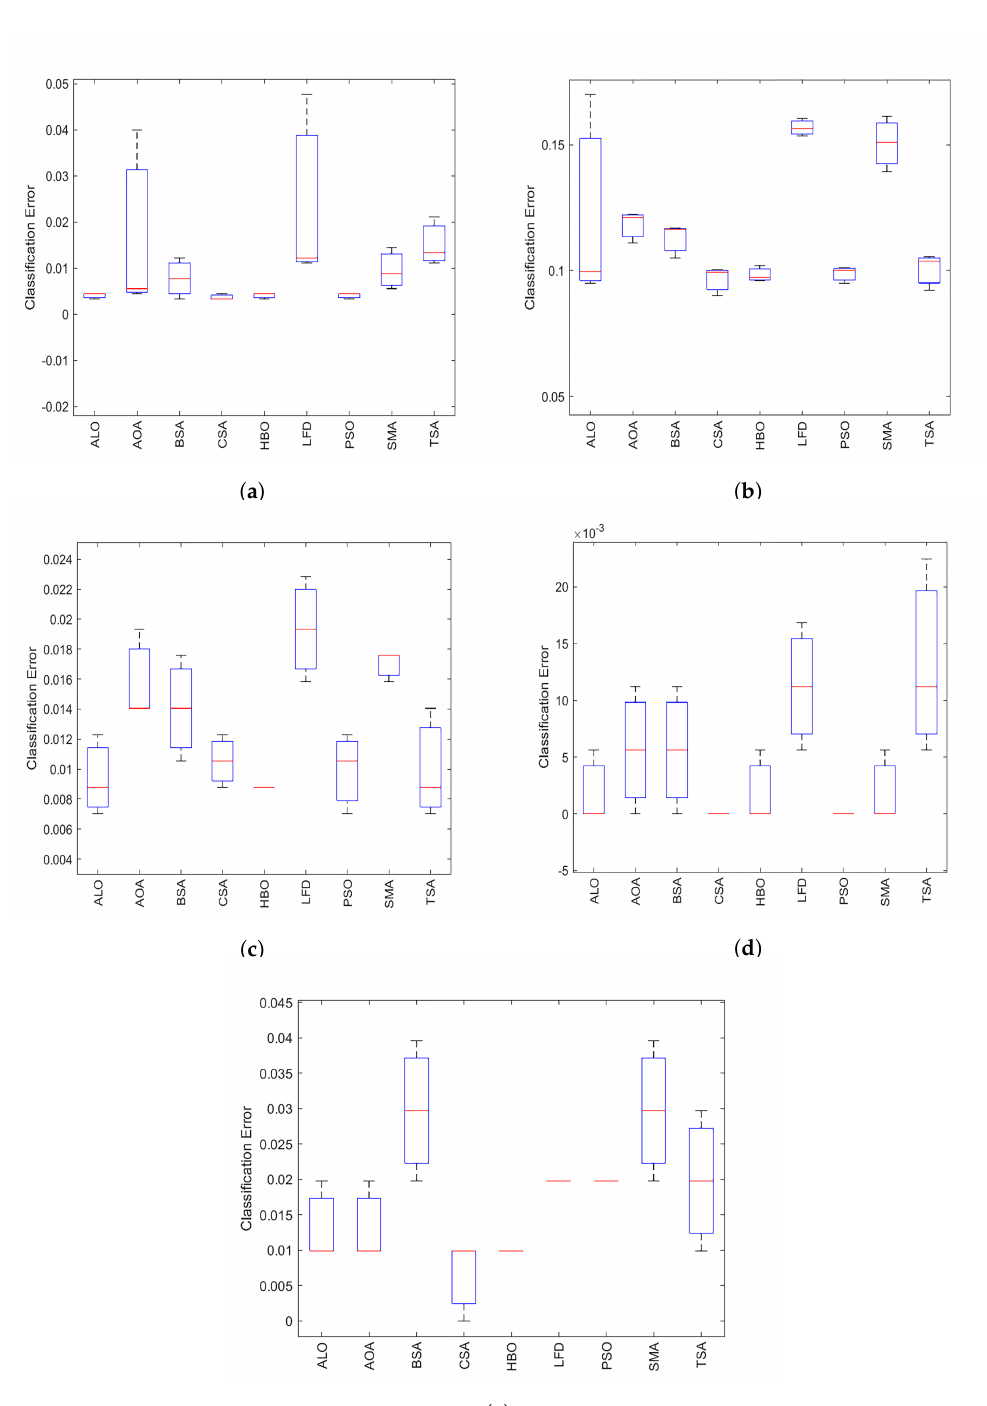
Figure 9. Boxplots of the results achieved by the B_HBO regarding classification error over Vowel, WaveformEW, WDBC, Wine, and Zoo datasets regarding classification error. ( a ) Classification error of the proposed approach for Vowel dataset. ( b ) Classification error of the proposed approach for WaveformEW dataset. ( c ) Classification error of the proposed approach for WDBC dataset. ( d ) Classification error of the proposed approach for Wine dataset. ( e ) Classification error of the proposed approach for Zoo